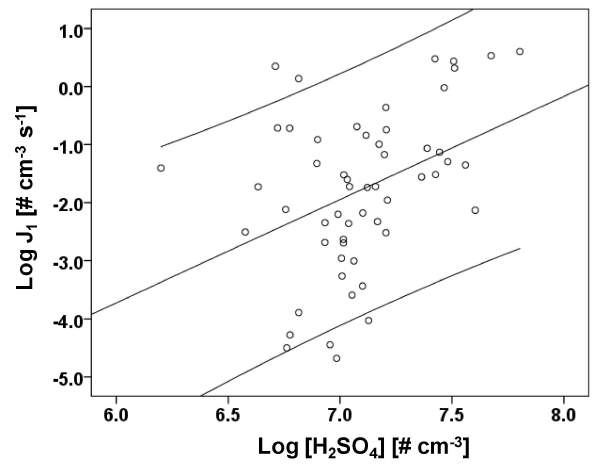
Fig. 1. Relationship between the base 10 logarithm of sulfuric acid concentrations [cm − 3 ] and the base 10 logarithm of the nucle- ation rate of 1nm particles [cm − 3 s − 1 ] during nucleation hours of class A events. The estimated regression coefficients are statisti- cally significant, giving a regression line of Log 10 J 1 = − 14 . 39 × Log 10 (cid:2) H 2 SO 4 (cid:3) 1 . 78 . The 90% confidence intervals for K ([ − 21.28, − 7.51]) and n ([0.81, 2.75]) are also